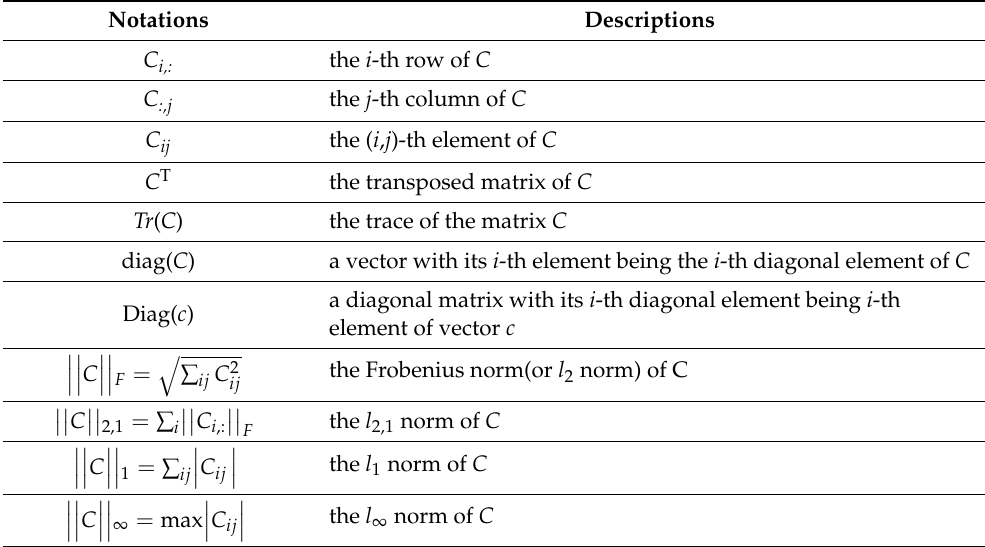
Table 1. The notations used in each